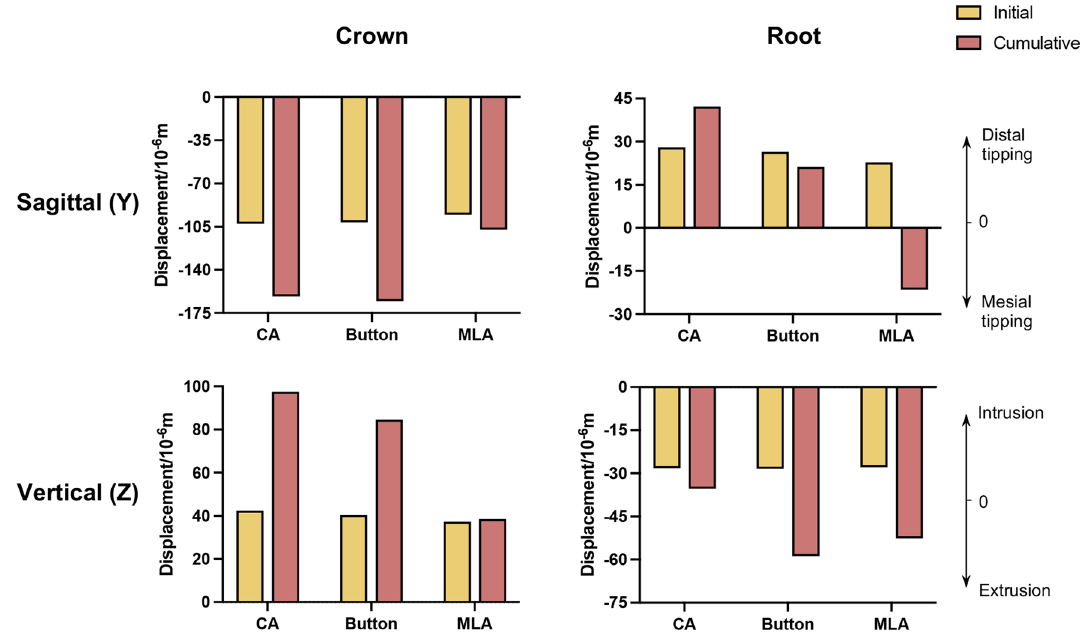
Fig. 8 The comparison of the initial displacement and the cumulative displacement